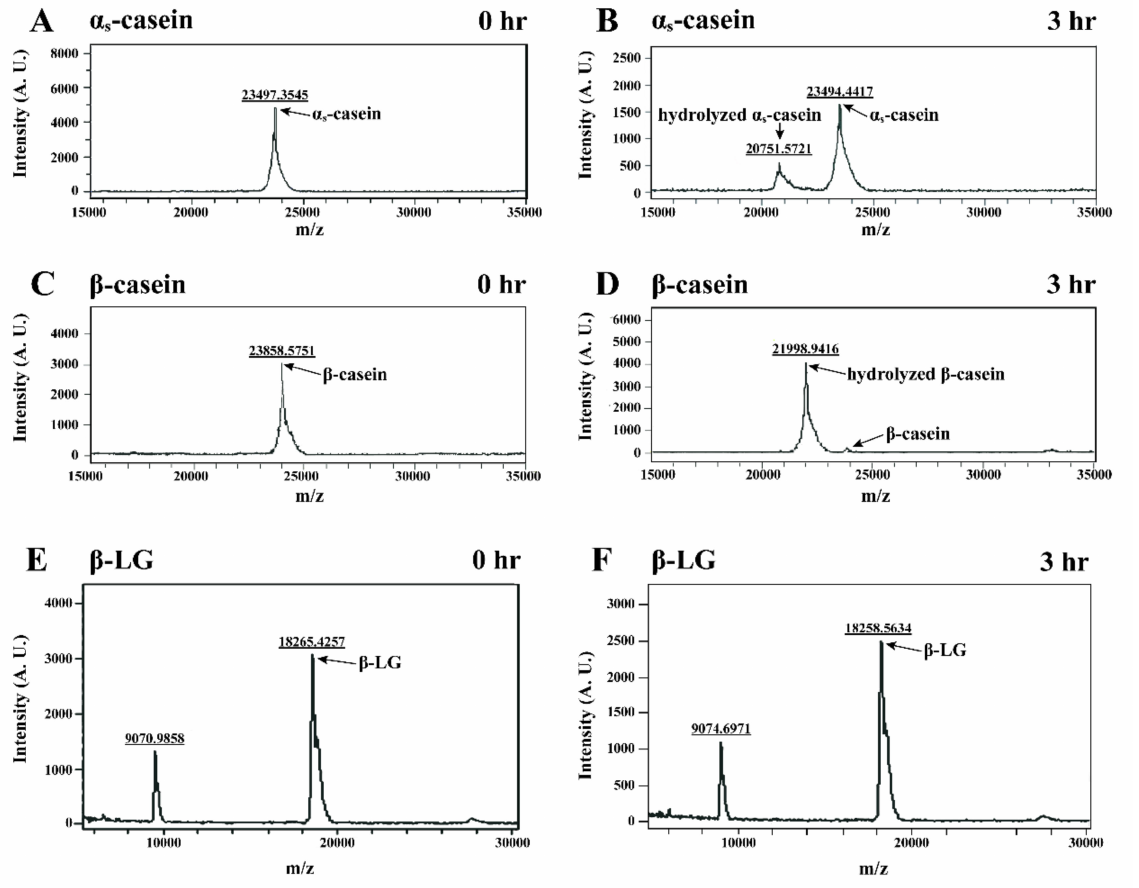
Figure 4. Mass spectrometry analysis of α s -CN, β -CN, and β -LG treated with chymosin (0.03 units/mL) at 30 ◦ C for 0 and 3 h. ( A ) α s -CN for 0 h; ( B ) α s -CN for 3 h; ( C ) β -CN for 0 h; ( D ) β -CN for 3 h; ( E ) β -LG for 0 h; ( F ) β -LG for 3